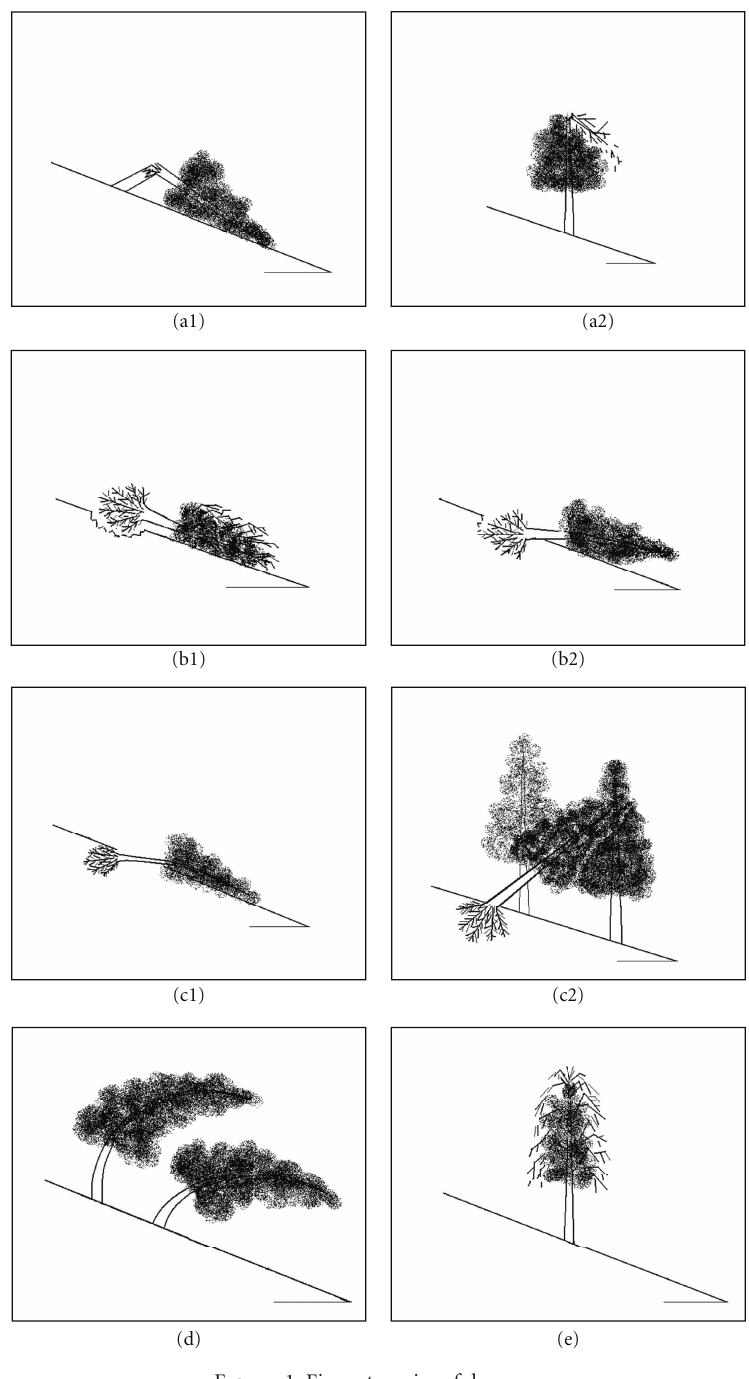
Figure 1: Five categories of